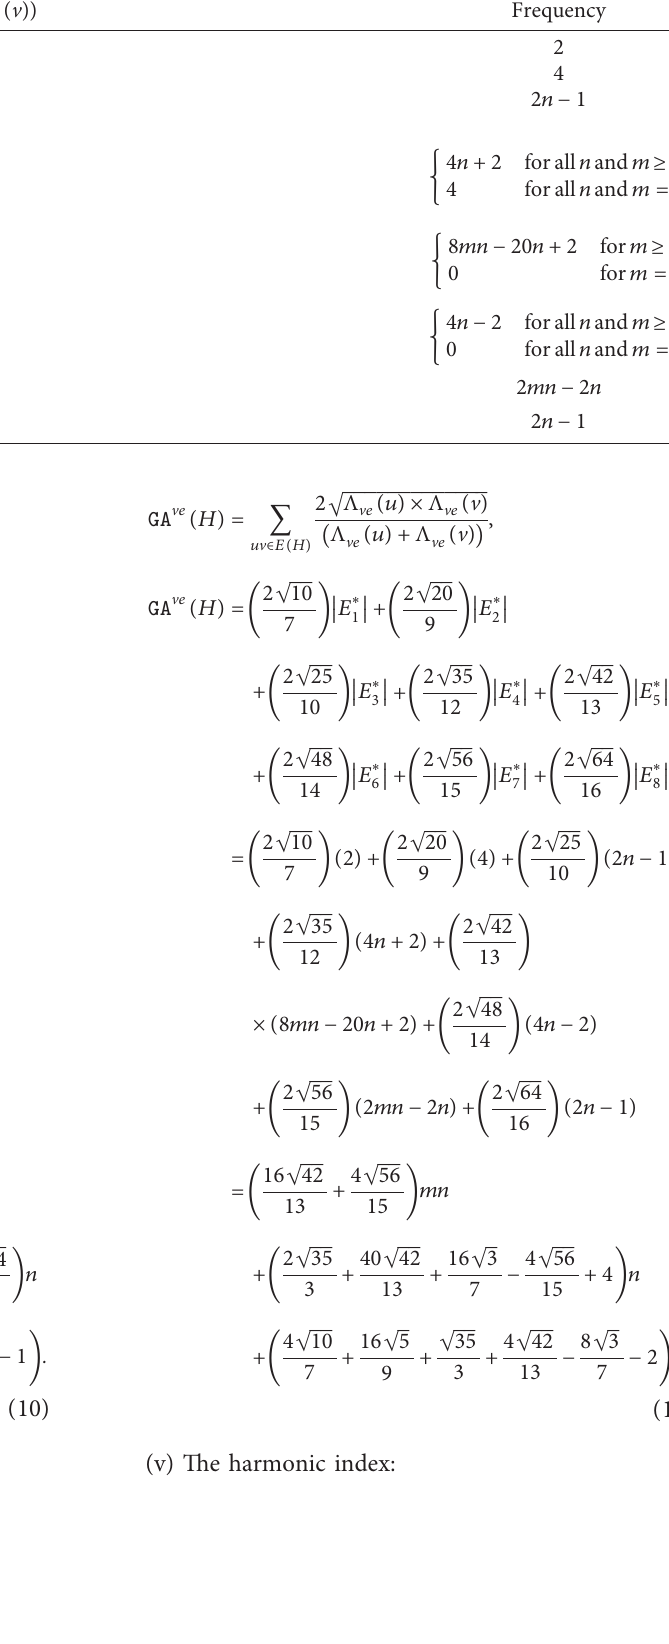
Table 3: End vertices’ ve-degrees of each edge of L [ m, n ]